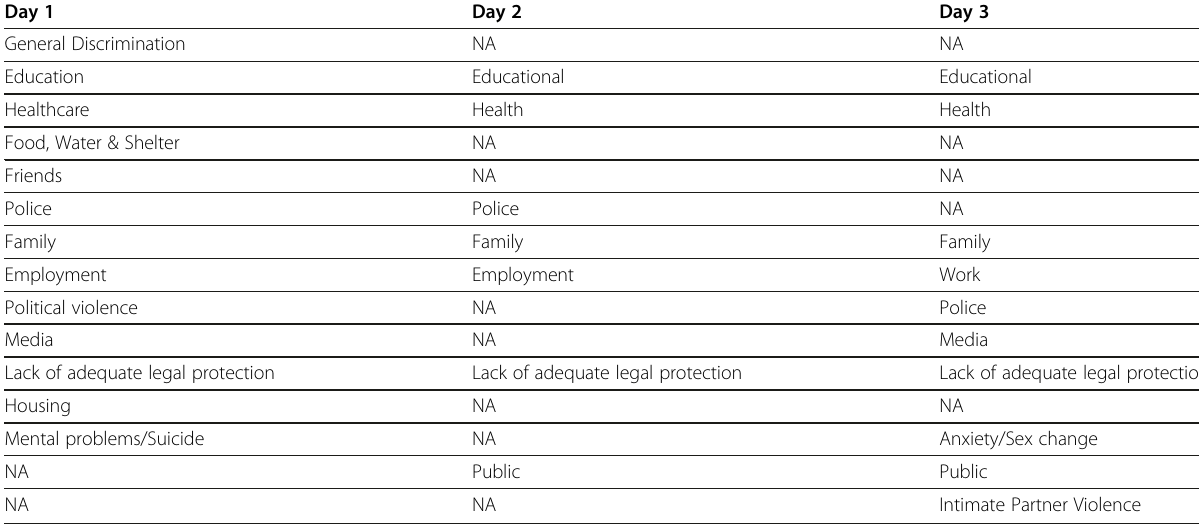
Table 1 Daily listing of domains of human rights violations among Sexual and Gender Minorities in Nepal